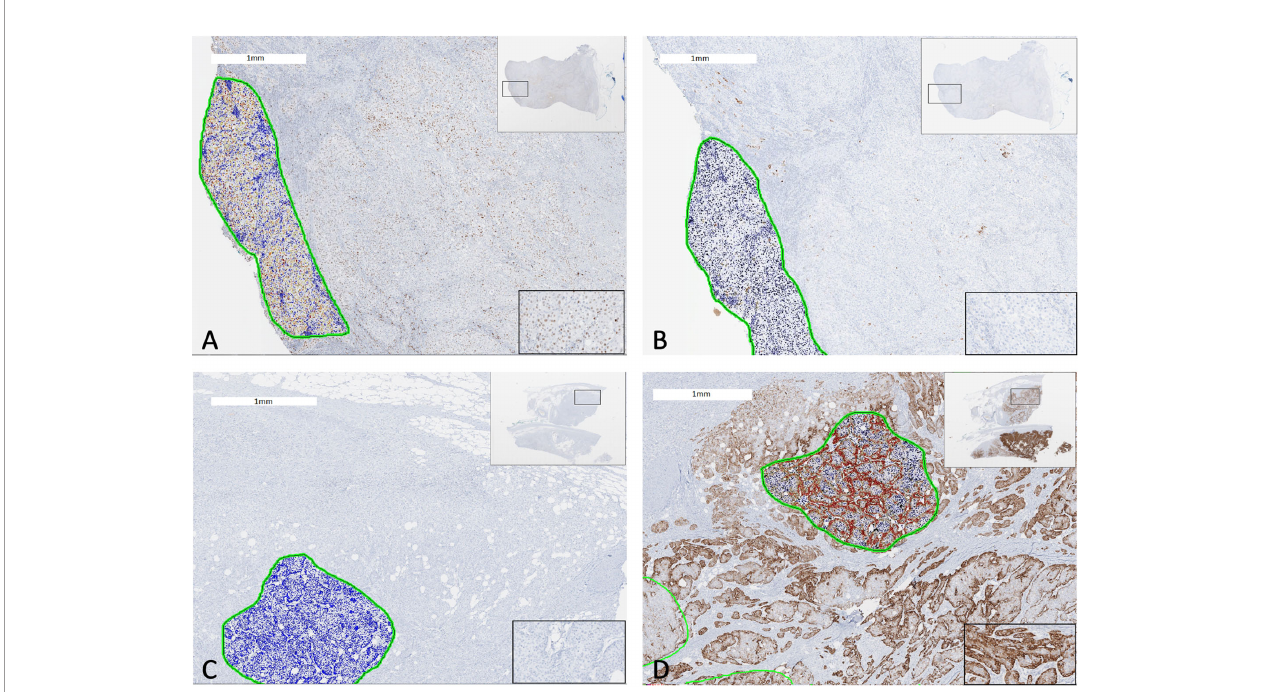
FIGURE 1 | Two cases of bladder cancer showing GATA3 and CK5/6 expression quanti fi ed by digital immunohistochemistry analysis. A luminal subtype bladder tumor with (A) GATA3 expression ≥ 20% and (B) CK5/6 expression <20% (Left: Anti-GATA3 Ab; Right: Anti-CK5/6 Ab). A basal subtype bladder tumor with (C) GATA3 expression <20% and (D) CK5/6 expression ≥ 20% (Left: Anti-GATA3 Ab; Right: Anti-CK5/6 Ab). The green circles represent tumor area analyzed by digital automated immunohistochemistry algorithm. Encircled blue cells/nuclei represents no staining with antibody whereas yellow, orange, brown, dark brown/ red ones represent positive staining incremental to staining intensity. Views of whole tumor section at the right upper corner and of a magni fi ed tumor area at the right lower